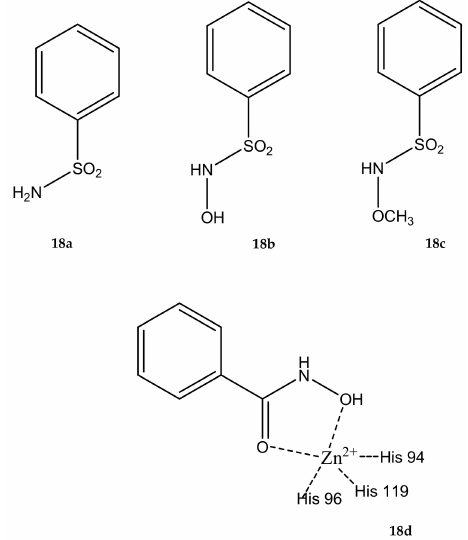
Figure 18. Compounds 18a – d